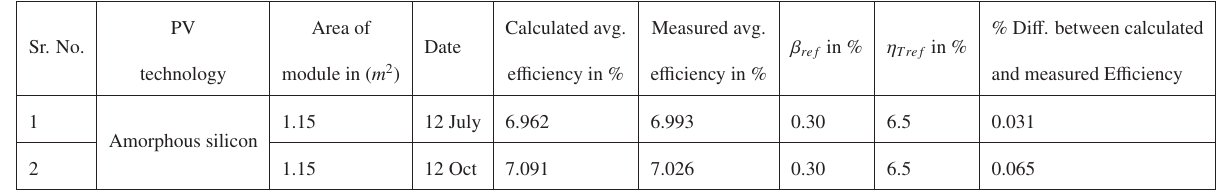
Table 2: Calculated photovoltaic module e ffi ciency for a-Si / thin film technology module. Sr. No.